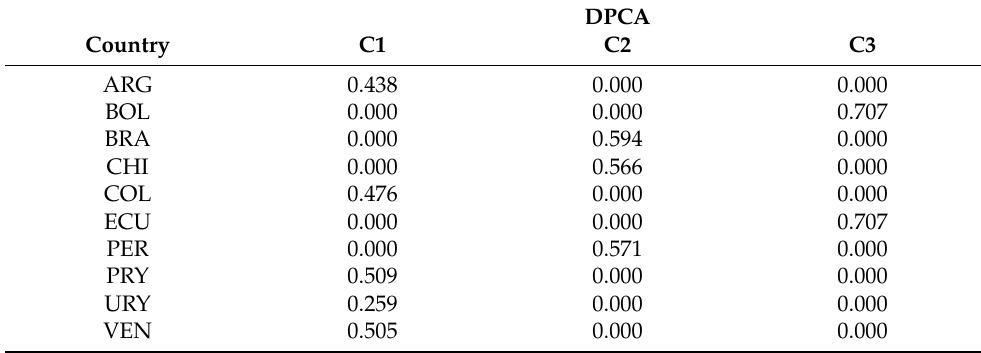
Table 6. Loading matrix for data on the number of COVID deaths with three components (C1, C2, and C3) for the indicated country using the DPCA.